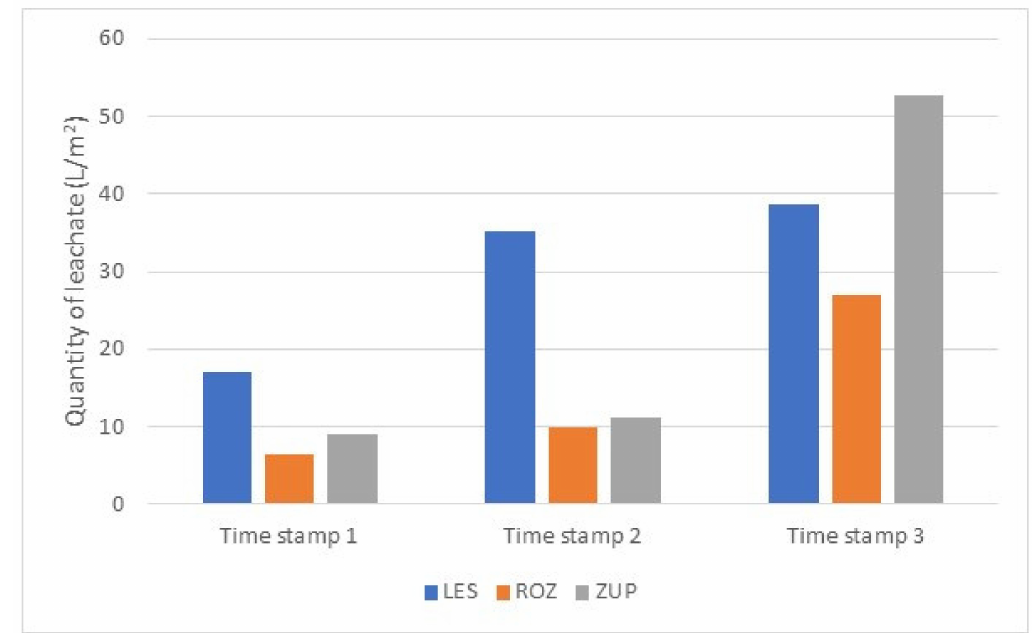
Figure 4. Leachate quantity over time (L/m 2 ) in relation to the composting procedure (LES, ROZ, ZUP) and Time stamp (1—first month of the process, 2—second month of the process, 3—November–April).